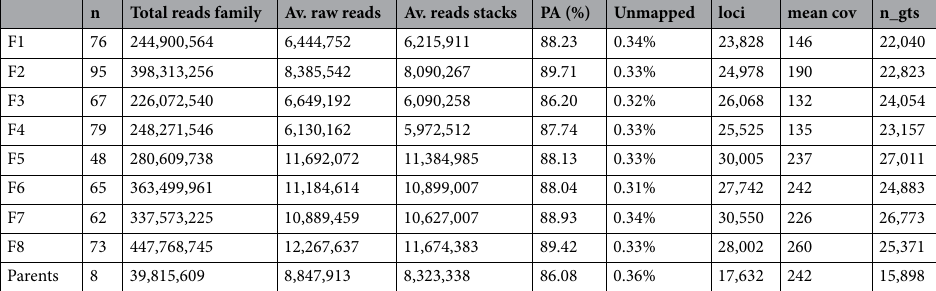
n Total reads family Av. raw reads Av. reads stacks PA (%) Unmapped loci